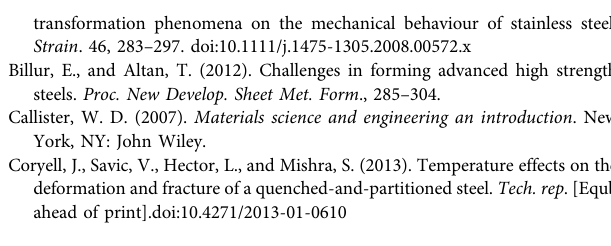
Frontiers in Materials |